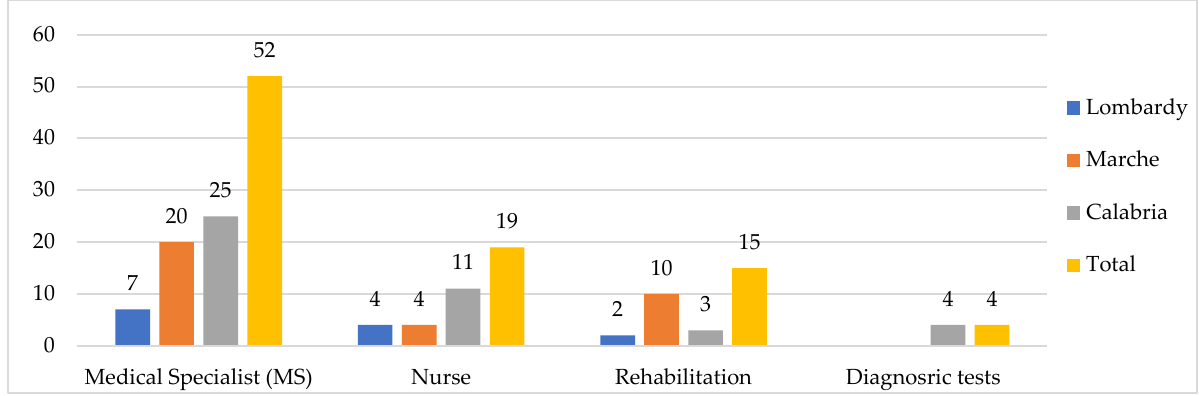
Figure 3. Private health services used by older people, by regions (n). Some respondents reported more than one type of listed private health services. MS was mainly cardiologist, physiatrist, orthopedist and diabetologist. Also, nurses at home for injections and withdrawals. Diagnostic tests were mainly blood/urine tests, ultrasound and electrocardiogram (ECG).